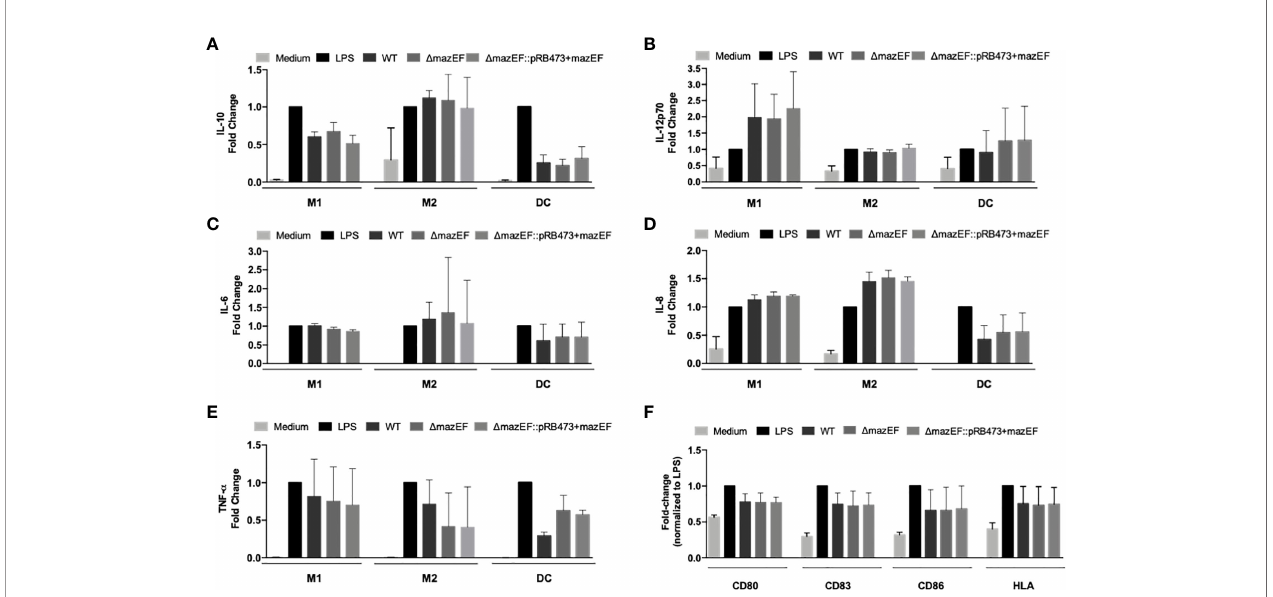
FIGURE 3 | Effect of mazEF homologue deletion in the response of mononuclear phagocytes. (A – E) Quanti fi cation of the cytokines secreted by human monocyte- derived M1- and M2-type macrophages (M1 and M2) and dendritic cells (DC) in cell-culture supernatants upon incubation with S. epidermidis cells at a MOI of 1 M1/ M2/DC:5 bacteria. (F) Cell surface expression of activation/maturation markers detected by fl ow cytometry on DC upon incubation with S. epidermidis cells at a MOI of 1 DC:5 bacteria. Cytokine levels and activation marker expression are presented as fold-changes to the respective values of positive control (LPS) samples. Bars correspond to means + standard deviation of at least 3 independent experiments, where each condition was set in duplicate. Statistical analysis was performed using One-way ANOVA with Tukey ’ s multiple comparison test. HLA, human leukocyte antigen.